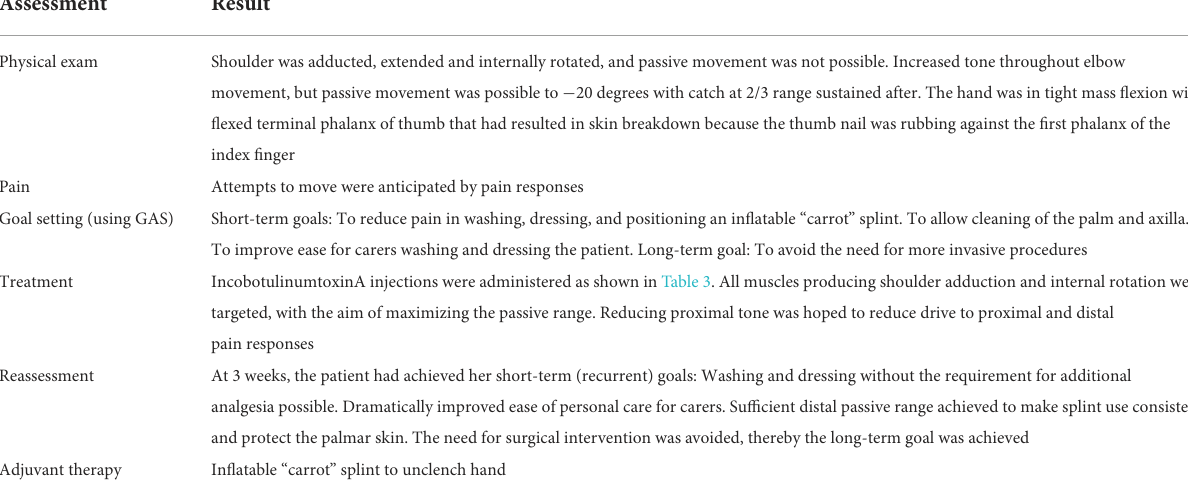
TABLE 4 Case 2: A female patient in her 60s who presented 12 years after traumatic brain injury with a rapidly evolving pattern of tone throughout the UL and shoulder and was a candidate for botulinum toxin injections.